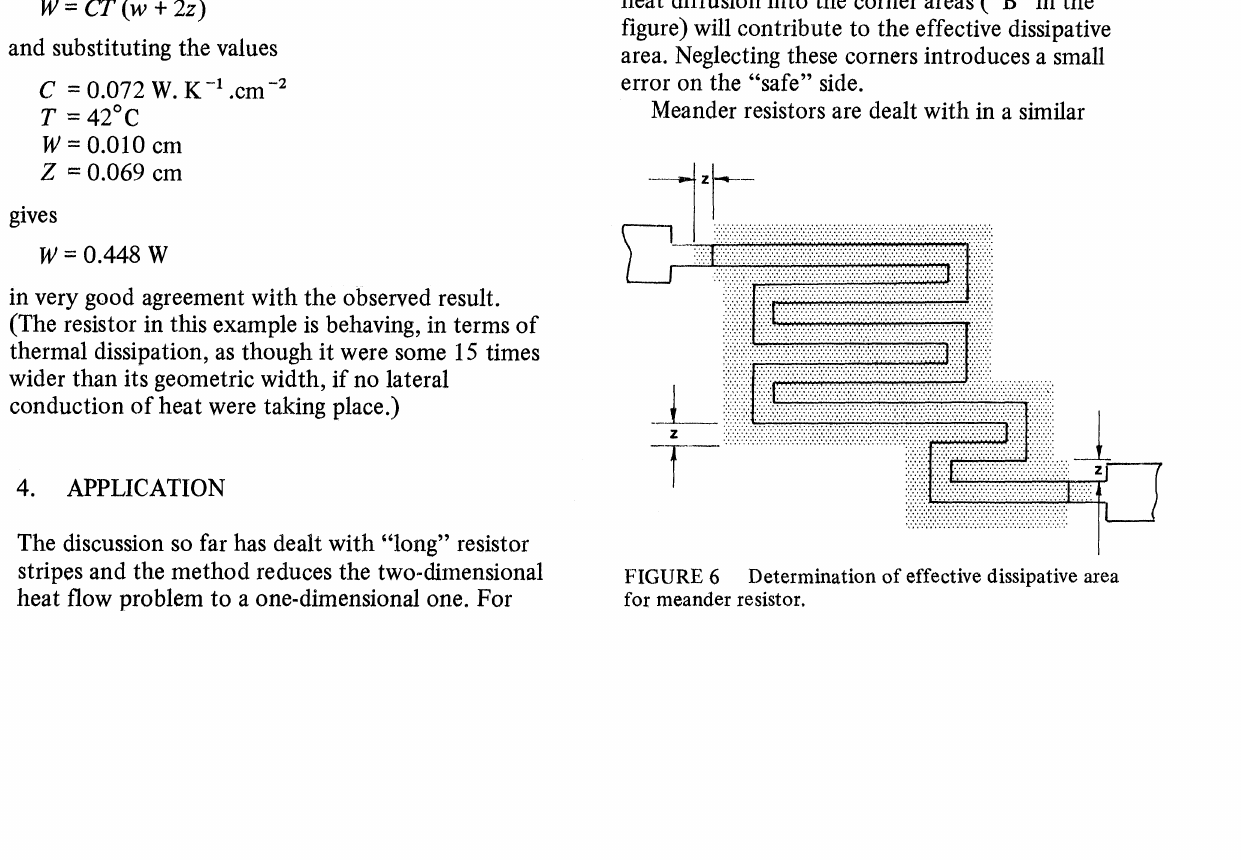
FIGURE 5 Determination of "effective dissipative area" A d.